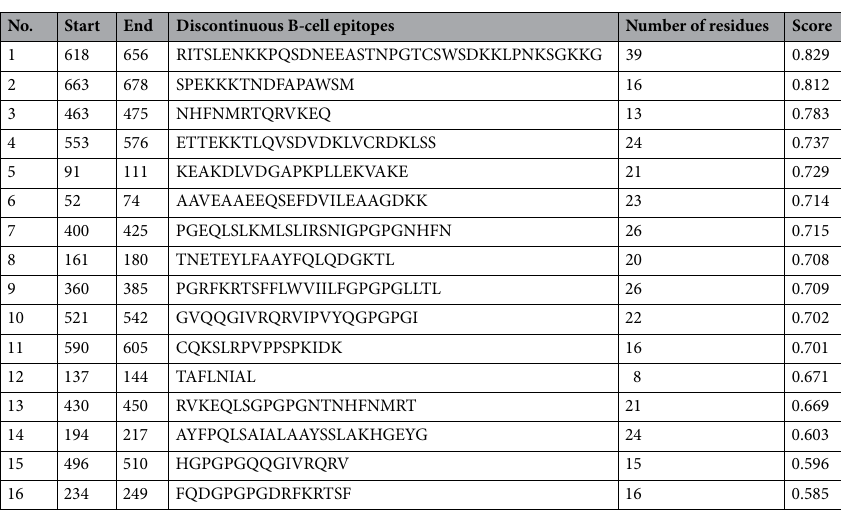
Table 4. Predicted discontinuous B-cell epitopes from the refined 3D model of the multi-epitope vaccine.